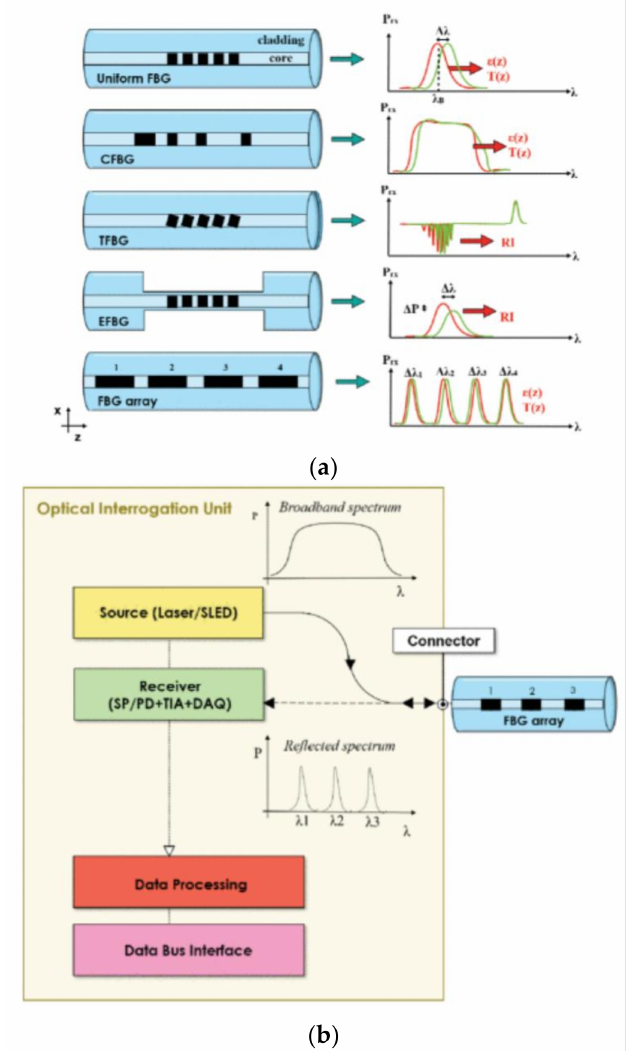
Figure 6. In the ( a ) panel, the main configurations of FBGs are shown. The spectral responses of the measured parameters (strain ( ε ), temperature (T), refractive index (RI)) are also reported. In the ( b ) panel, a schematic representation of the developed device with all the components used with FBGs is presented. (Reprinted-rearranged-with permission from [36] under Open Access